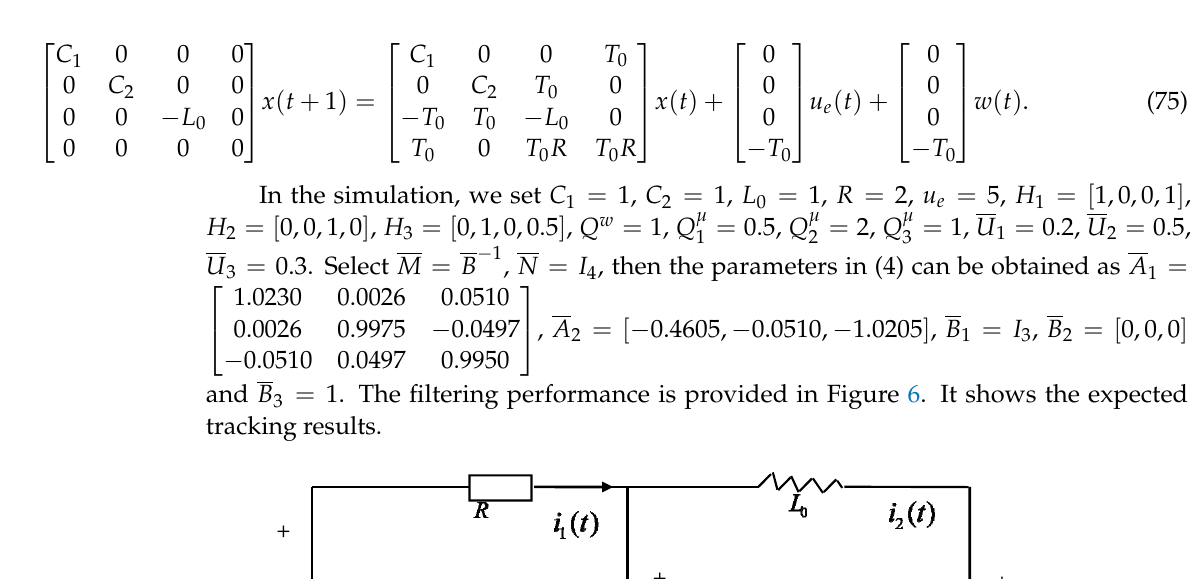
current of C 1 . ( d ) The current of C 2 C . ( d ) The current of current of 1